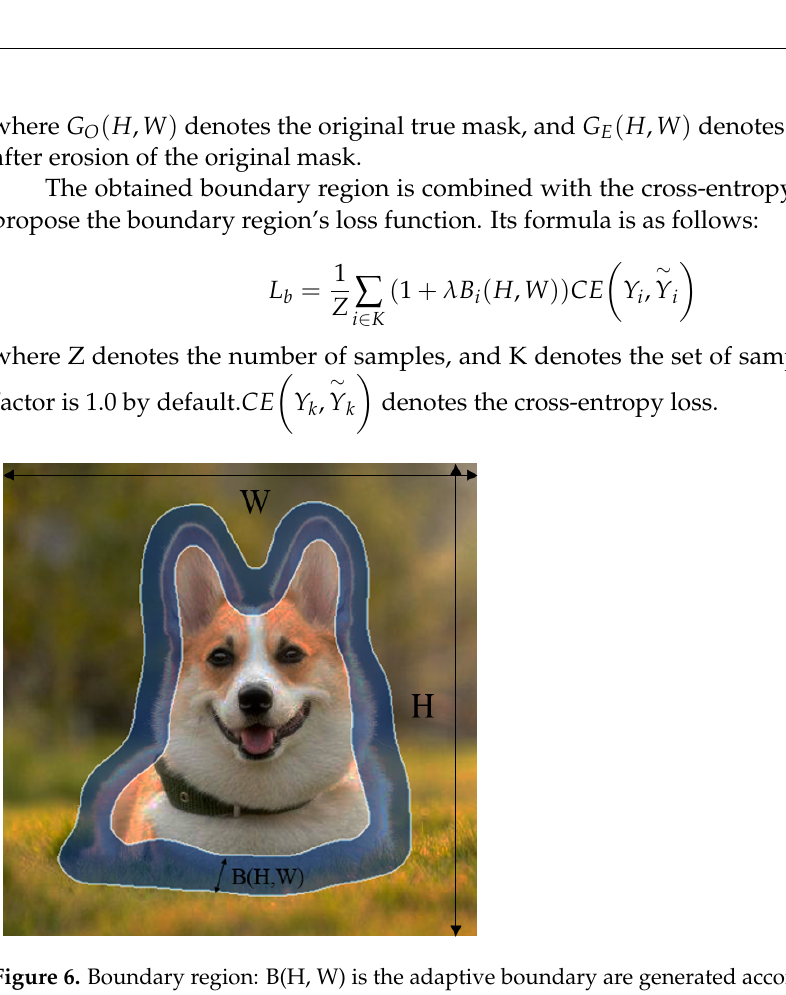
Figure 6. Boundary region: B(H, W) is the adaptive boundary are generated according to image size. The label’s width and height are W and H,